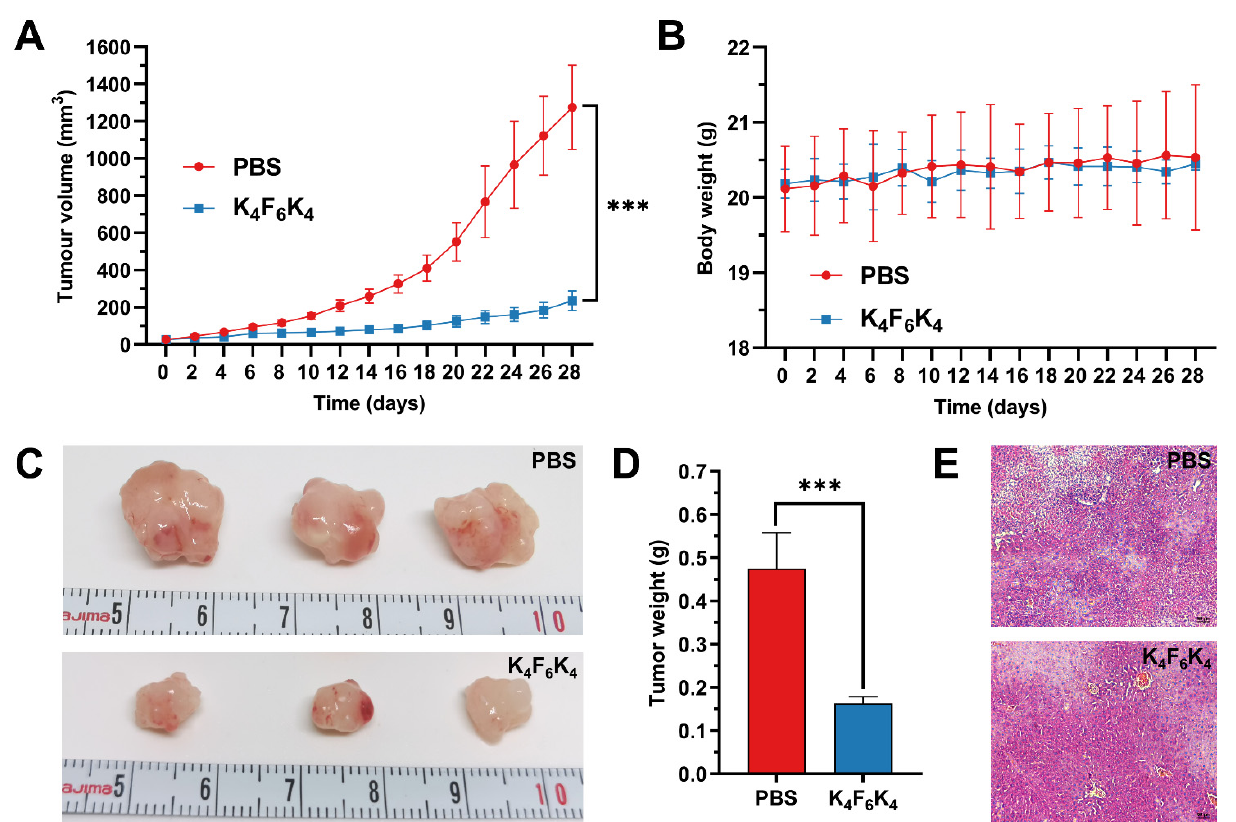
Figure 7. The therapeutic effects of K ₄ F ₆ K ₄ on tumor growth in nude BALB/c mice. ( A ) The mean tumor volume and ( B ) body weight of mice during the treatment process. ( C ) Photos of the excised tumors after the treatment of PBS and K ₄ F ₆ K ₄ . ( D ) Statistical analysis of the excised tumor weights after the experiment. ( E ) HE staining of the liver tissue with the treatment of PBS and K ₄ F ₆ K ₄ after the experiment. Data are expressed as the mean ± standard deviation. *** p < 0.001 vs. the PBS group.